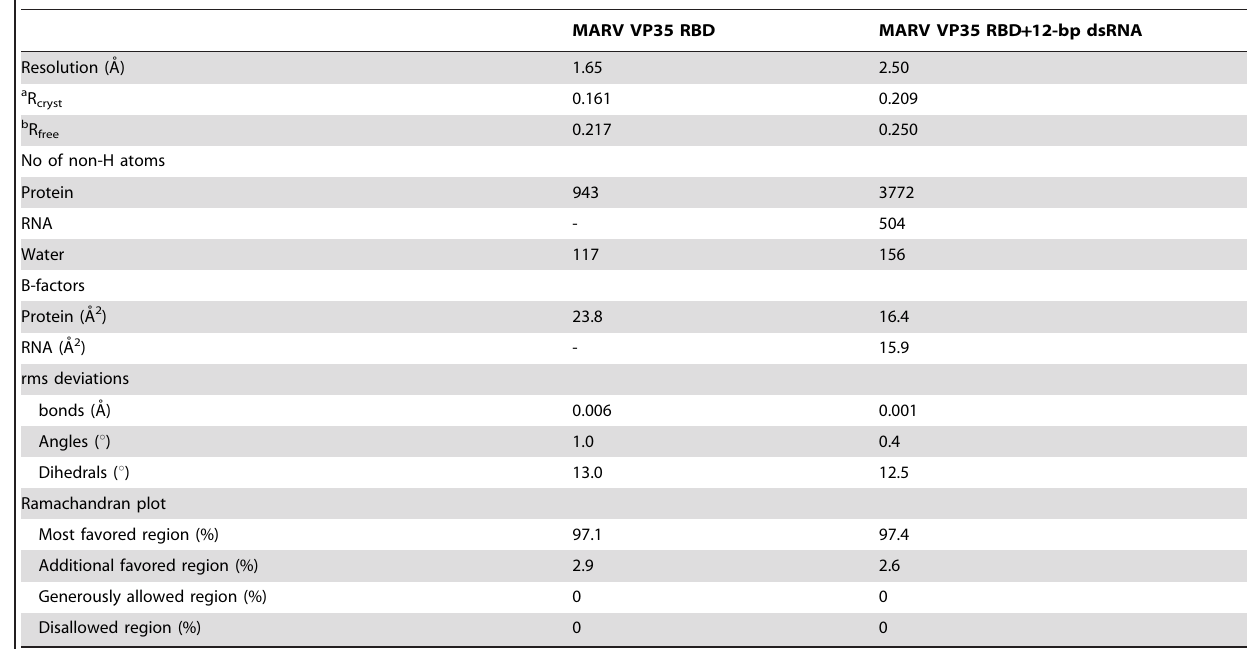
Table 2. Refinement